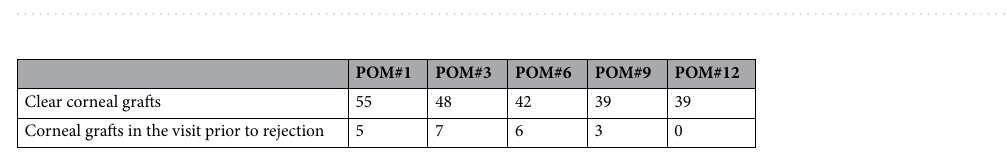
Figure 1. linear plots of the longitudinal repeated measures showing a significant increase ( p = 0.01) in the mean central Endothelium-Descemet’s complex thickness (En/DMTs, left plot) in the corneal transplants, versus the insignificant changes ( p = 0.7) of the central corneal thickness (CCT, right plot) through the visit prior to rejection during the 1st year postoperatively.